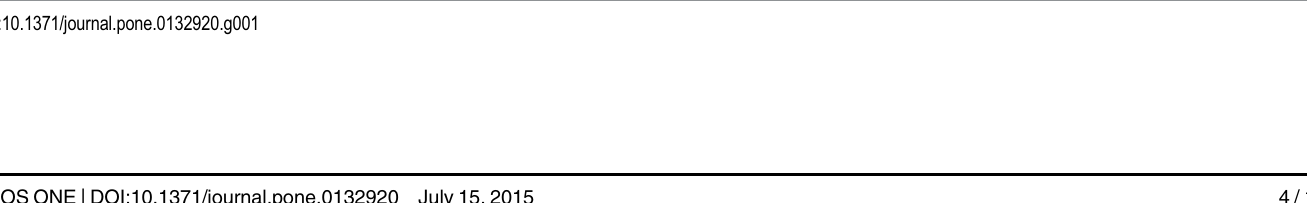
PLOS ONE | DOI:10.1371/journal.pone.0132920 July 15,